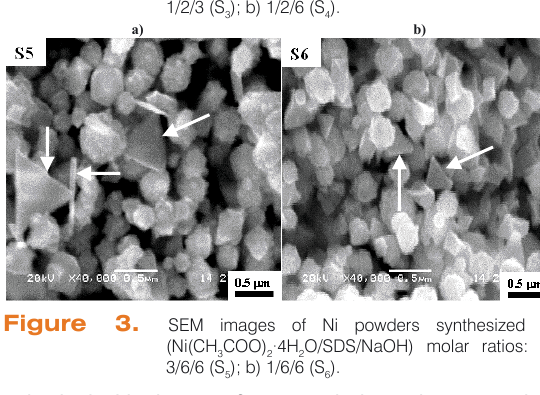
Figure 2. SEM images of Ni powders synthesized at (Ni(CH